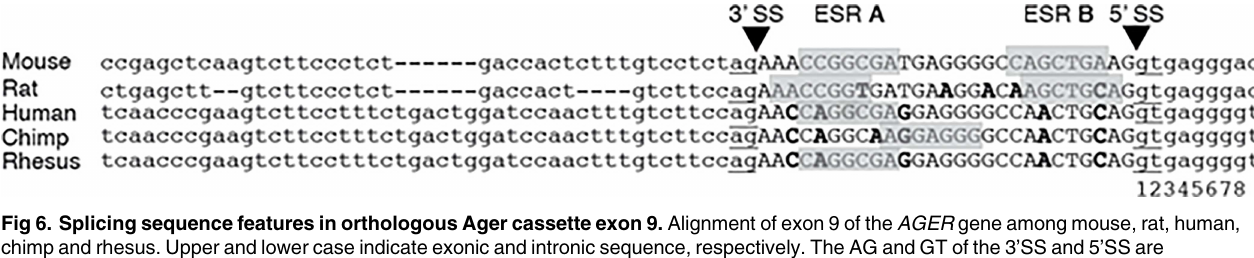
PLOS ONE | DOI:10.1371/journal.pone.0153832 September 21,